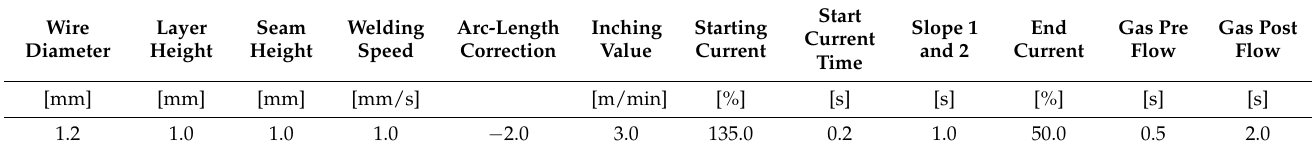
Table 2. Constant welding, motion and geometric